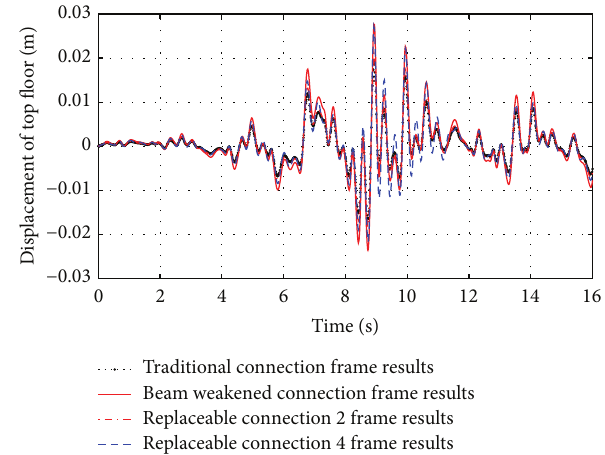
Figure 25: Displacement history of top